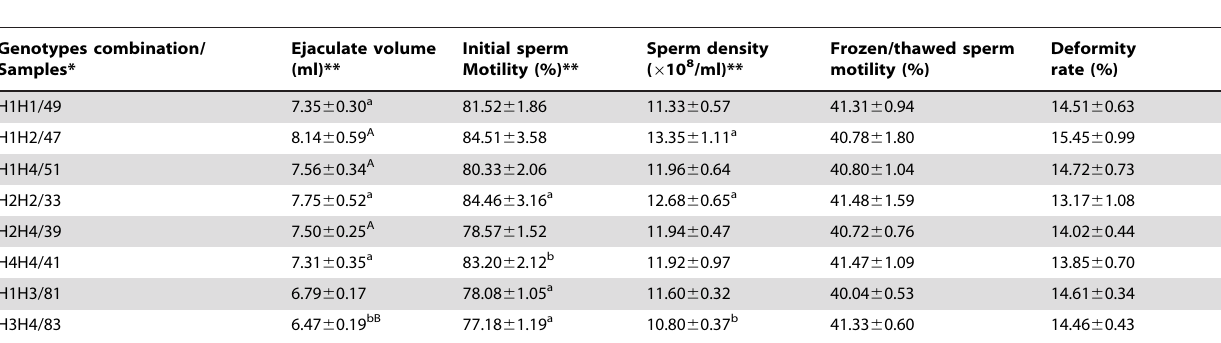
Table 4. Least square mean (LSM) and standard error (SE) for semen quality traits of different PLCz haplotype combinations in Chinese Holstein